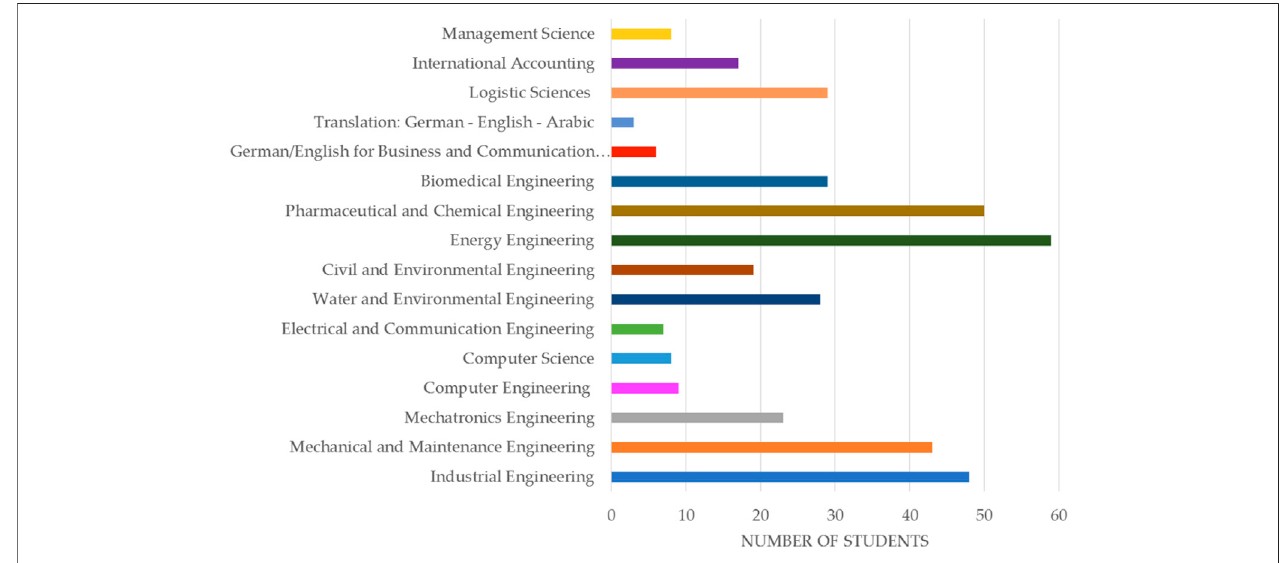
FIGURE 3 | Frequency of GJU-majors participating in the questionnaire.